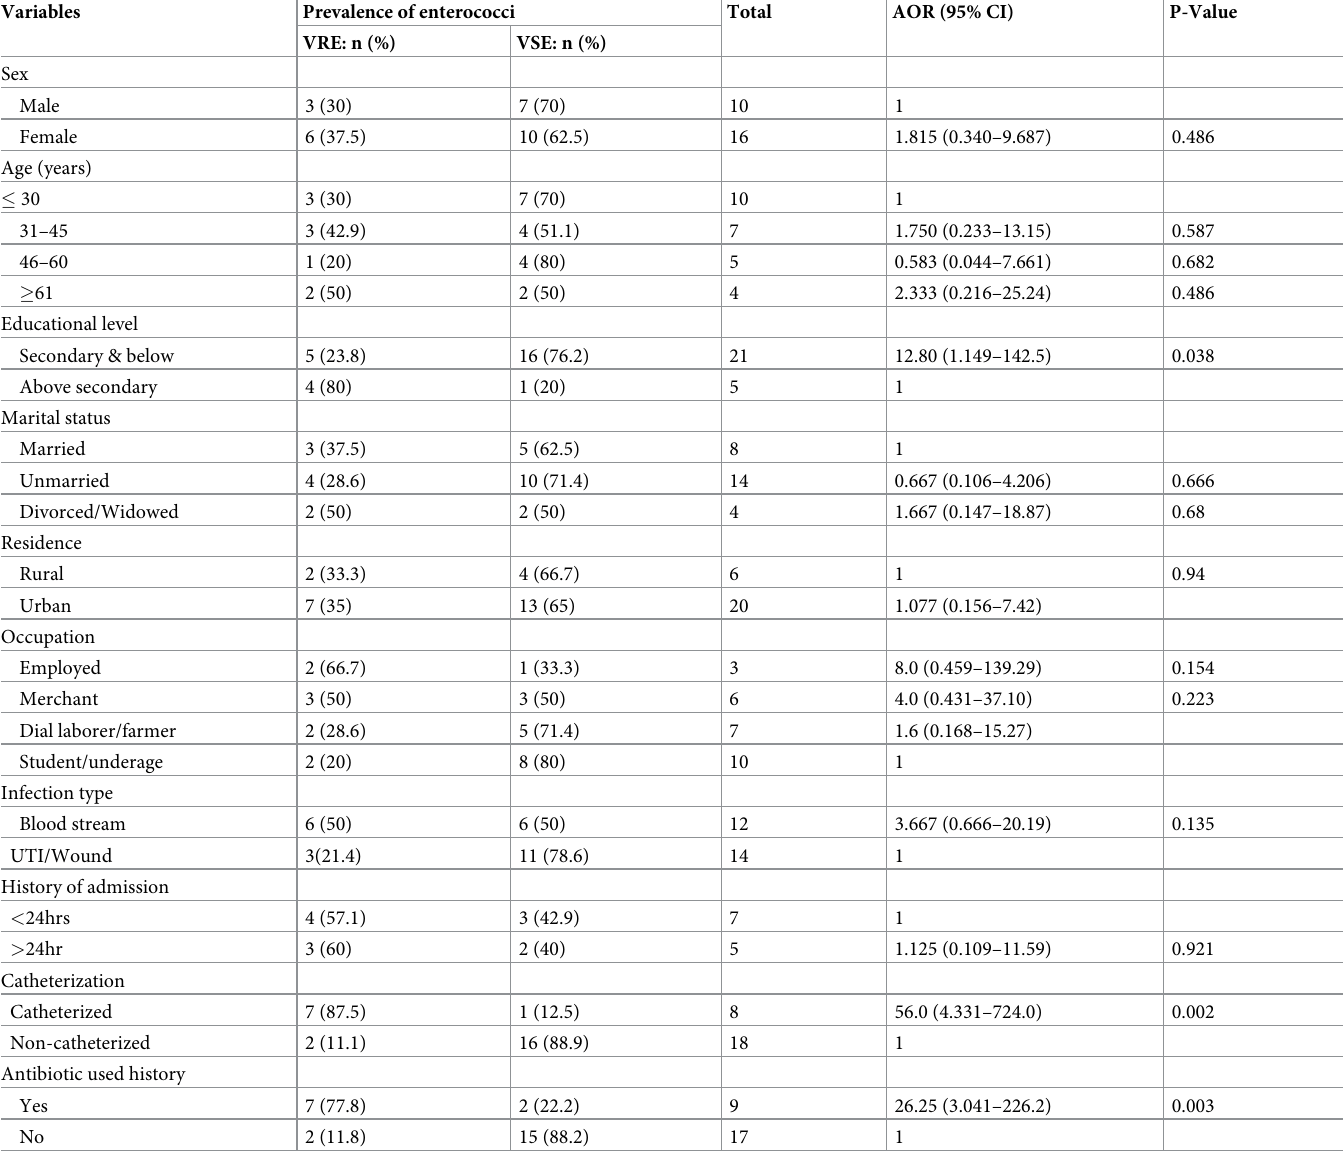
Table 5. Multivariable analysis on the associated factors of VRE infection among patients attending at FHSCH, Bahir Dar, Ethiopia, 2020.